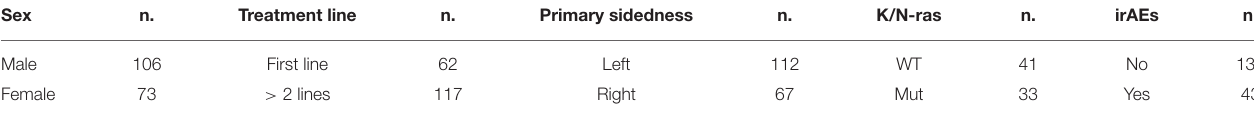
TABLE 1 | Clinical features of 179 mCRC patients who received GOLFIG chemo-immunotherapy between June 2002 and June 2018.